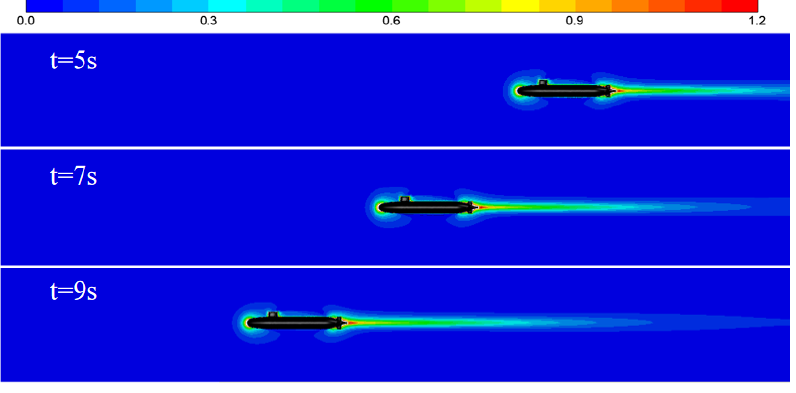
Figure 5. Wake evolution of submarine at a constant speed.